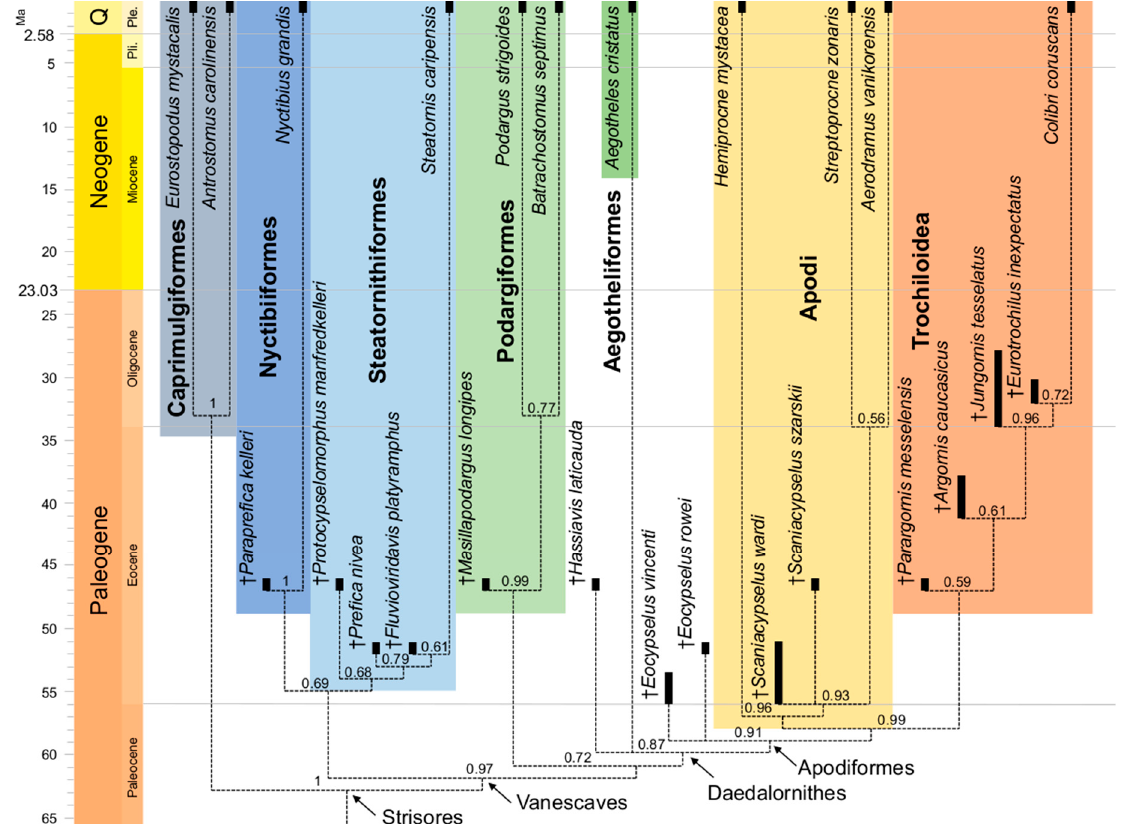
Figure 6. 50% majority-rule tree resulting from Analysis 5 (run with only morphological data, with relationships of all extant taxa constrained by a molecular scaffold) scaled to geologic time. For MrBayes output tree showing inferred branch lengths, see Figure S2. Dagger (†) indicates extinct taxa. Age ranges for fossil taxa include stratigraphic uncertainty and are based on Mayr [30,39] and Ksepka and Clarke [54]. Timing of divergence between Eurostopodus and Antrostomus and between Streptoprocne and Aerodramus are based on Prum et al. [3]. Timing of divergence between Podargus and Batrachostomus has not been estimated by any recent study and was arbitrarily chosen for this figure. The ages of other divergences represent minimum estimates constrained by the ages of fossil taxa, though a Paleocene origin of crown-Strisores has been favored by several recent studies [3,44,75]. Numbers on nodes represent Bayesian posterior probabilities.